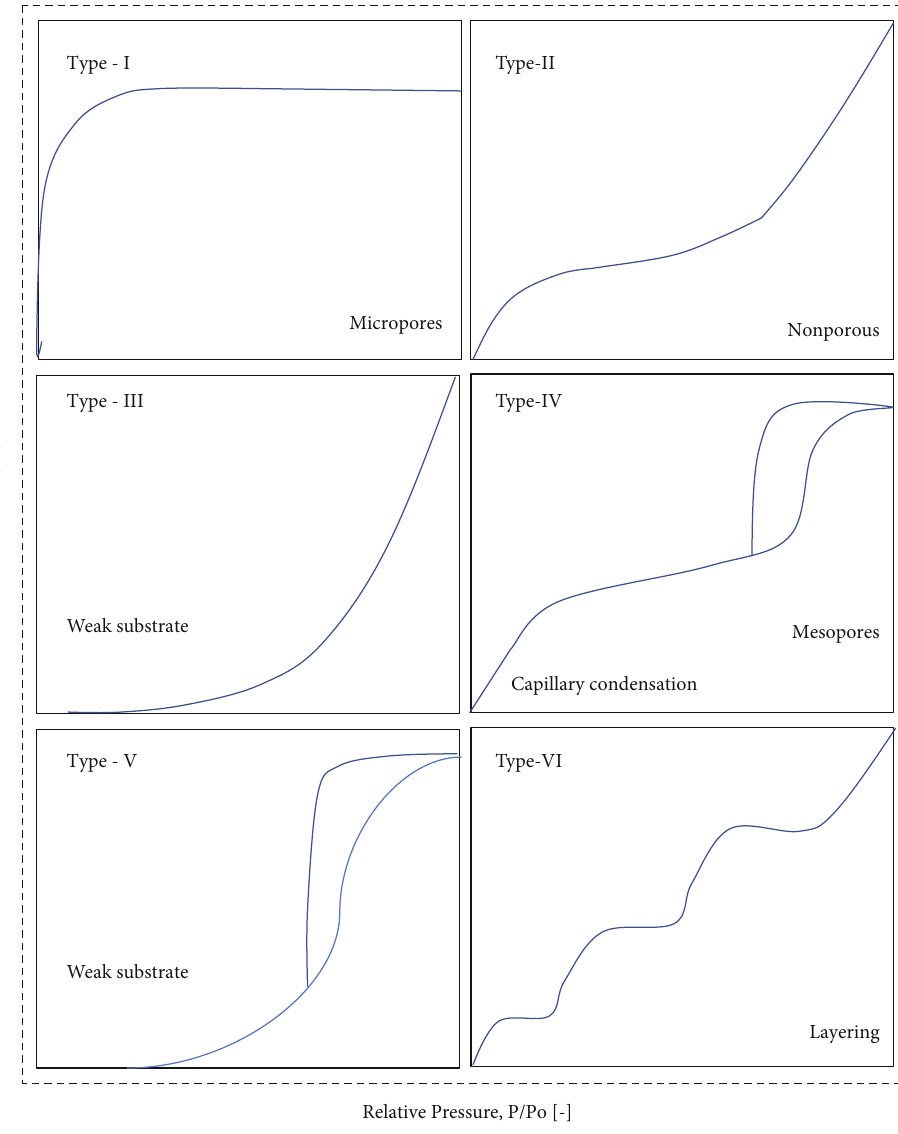
Figure 2: IUPAC classi fi cation of adsorption isotherms